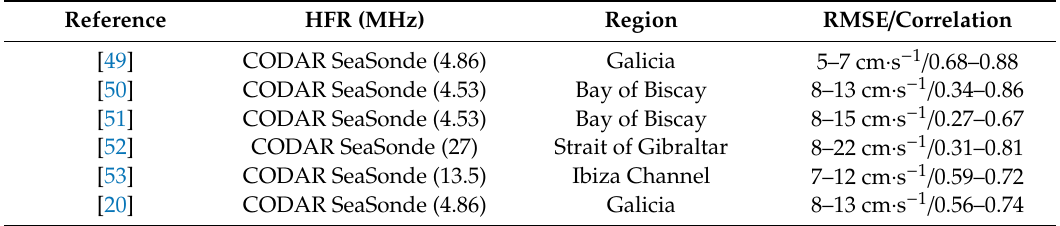
Table 3. Series of prior studies dealing with the validation of HFR total current vectors against in situ observations in the Iberian waters.